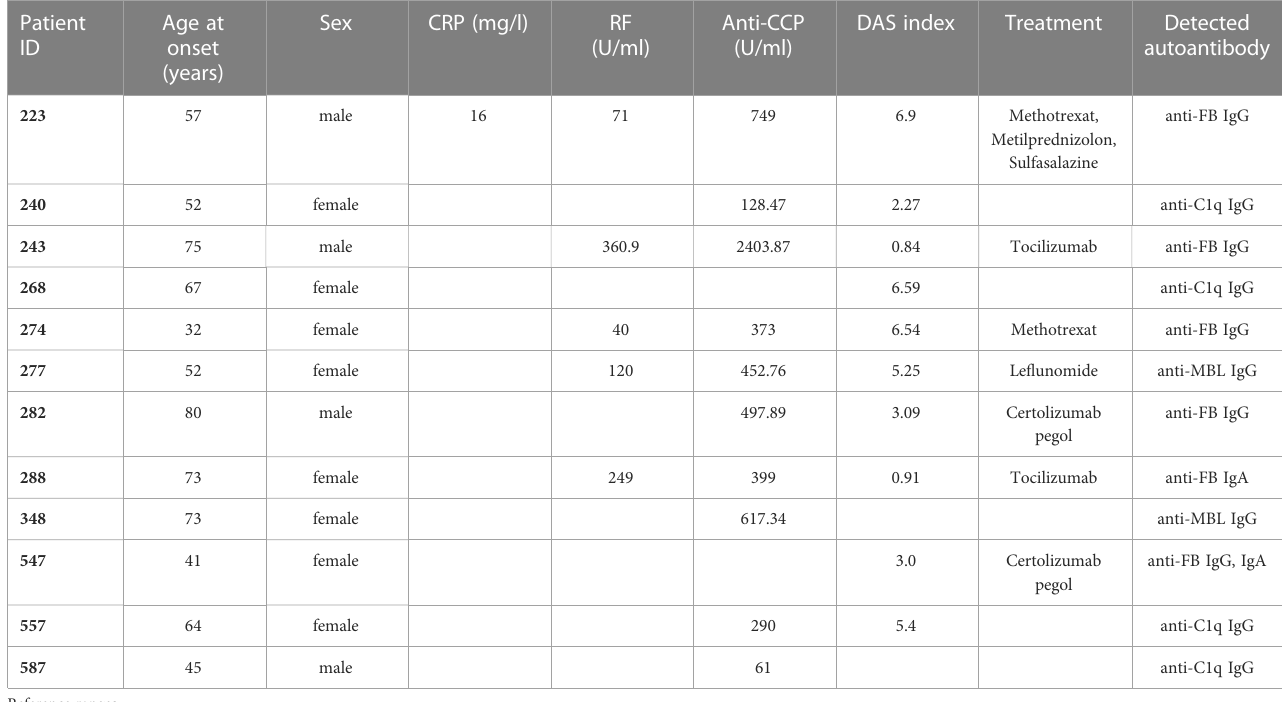
Reference ranges: RF (rheumatoid factor): >20 U/ml positive.